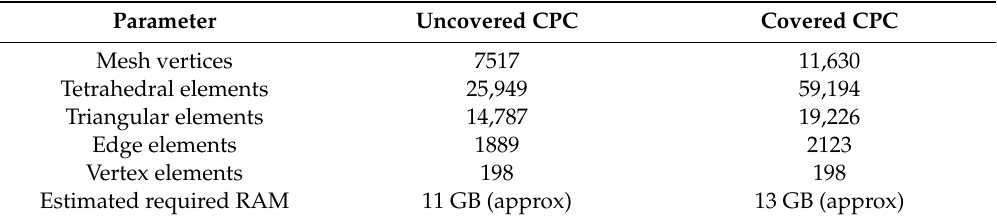
Table 4. Mesh characteristics for both CPC